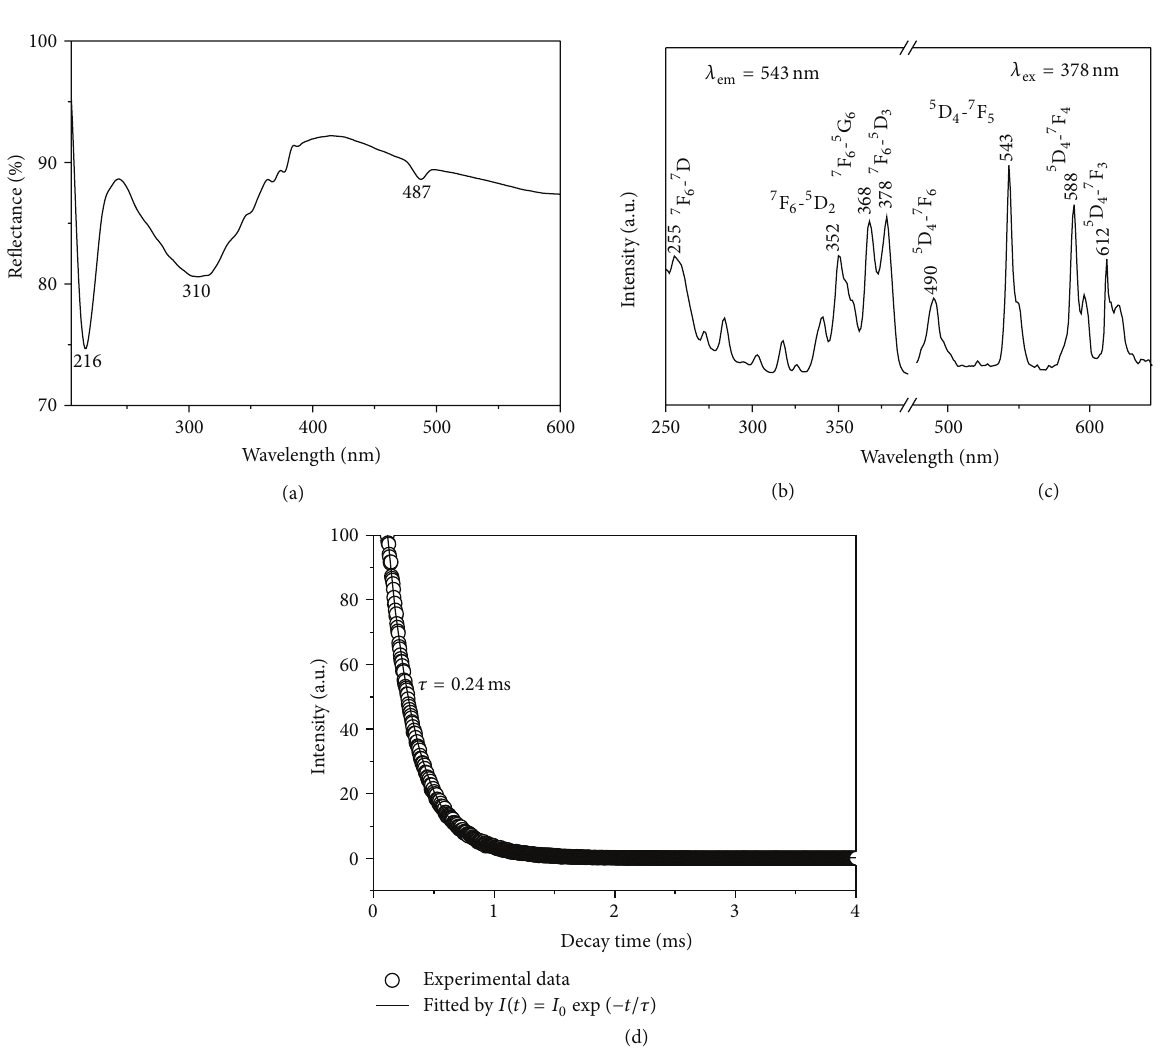
(oriented attachment) to form bundle-shaped